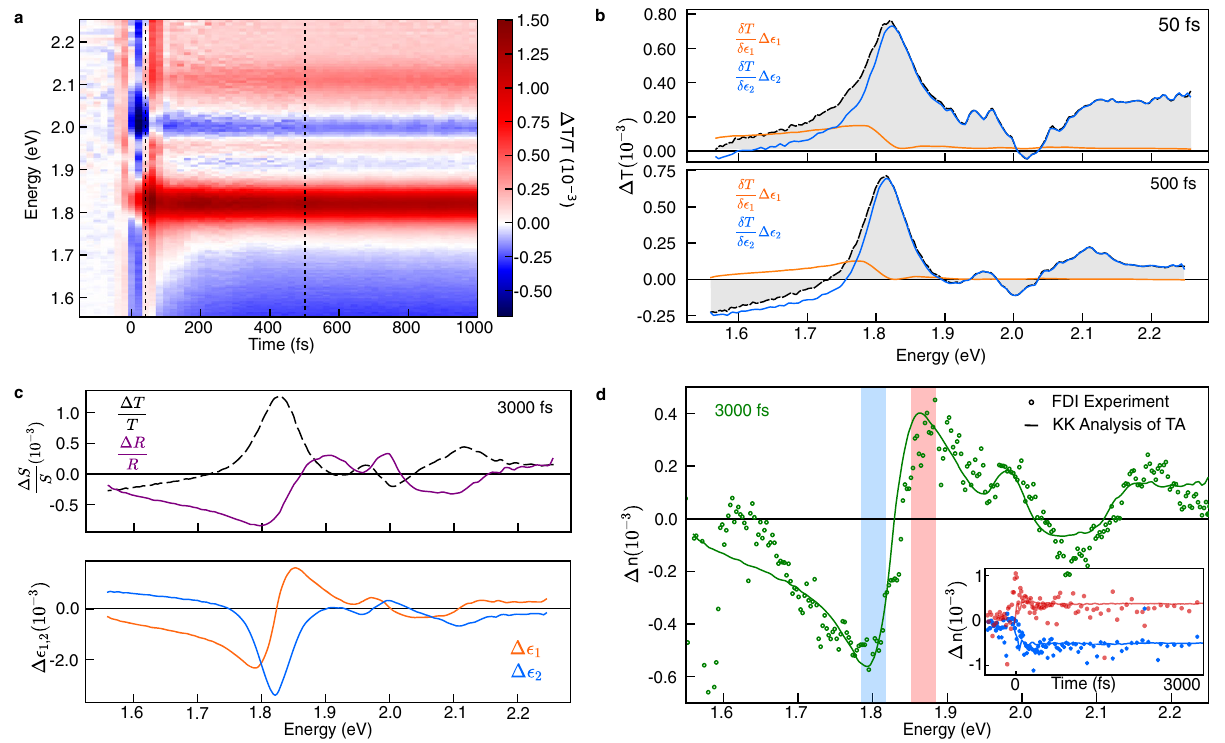
Fig. 3 Extraction and benchmarking of the femtosecond transient dielectric function of Pentacene. a Broadband transient transmission spectrum of pentacene. b Contribution of changes in the real and imaginary part of the dielectric function to the measured transient transmission at 25 and 500 fs, demonstrating that transient transmission on the low energy feature has signi fi cant contributions from the real part of the dielectric function. c The transient dielectric function and normalised transient spectra S( ω ) computed from the measured differential transmission at 3000 fs demonstrating that neither the transient re fl ection and transmission capture the spectral information of Δ ε 2 exactly. d Comparison of the extracted Δ n( ω ) with that retrieved from a time-resolved frequency domain interferometry (FDI) experiment on the same sample. Inset: Comparison of Δ n( ω ) kinetics over the two spectral bands